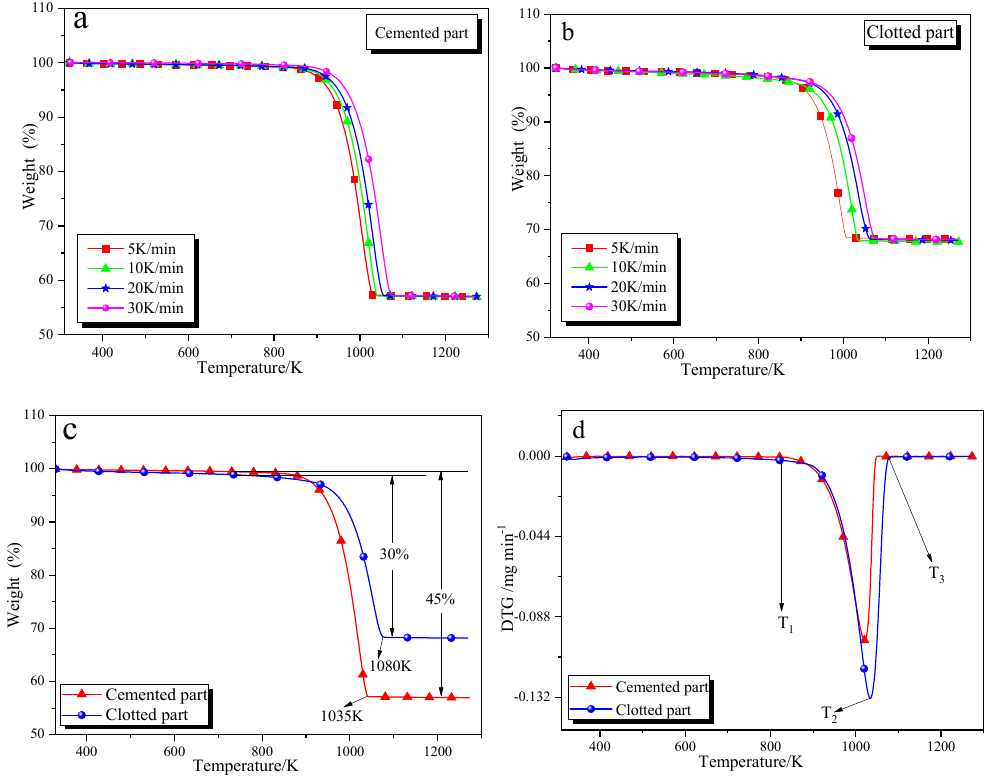
Figure 5. Thermal decomposition characteristics of cemented and clotted parts; ( a , b ) the thermal